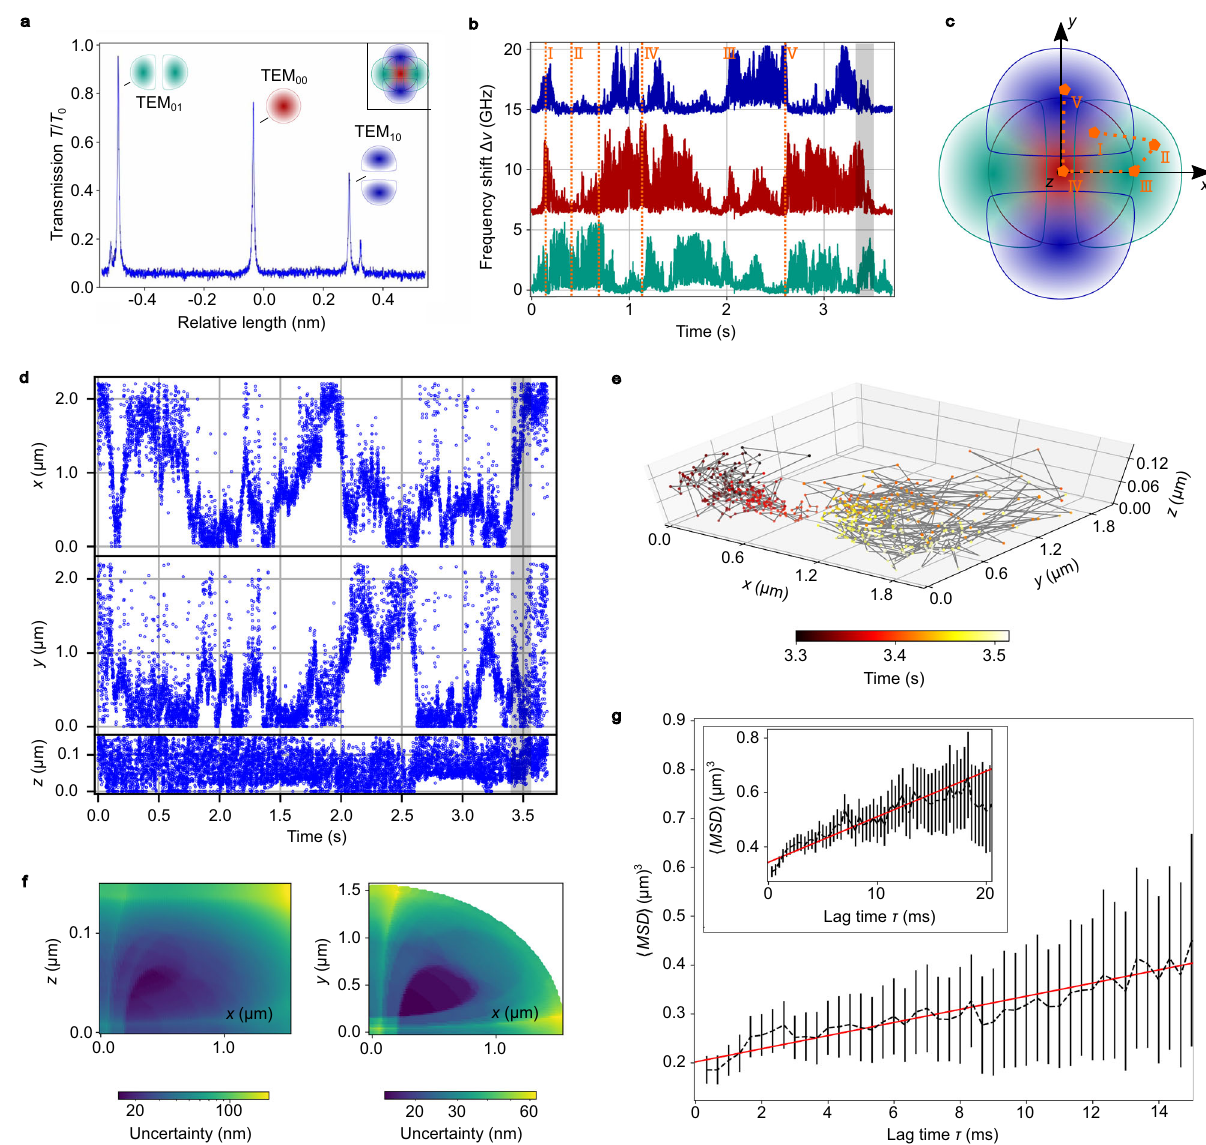
Fig. 3 Three-dimensional tracking of a single SiO 2 nanosphere and determination of its diffusivity. a Cavity transmission signal T / T 0 with the three evaluated transverse modes TEM 00 , TEM 01 , and TEM 10 indicated. Inset: Schematic illustration of the complementary spatial regions covered by the modes. b Time trace of frequency shifts of the three modes. c Sketch of particle positions at different times depicted in ( b ). d Evaluated positions by taking the mean position at a given time. e Three-dimensional representation of the position tracking. f Calculated position-dependent localization uncertainty. g Mean squared displacement (MSD) for the single transit event shown in d and the MSD averaged over fi ve single nanoparticle transit events (inset). The black error bars represent the statistical error (×10 for visibility) and the red line is a weighted linear fi